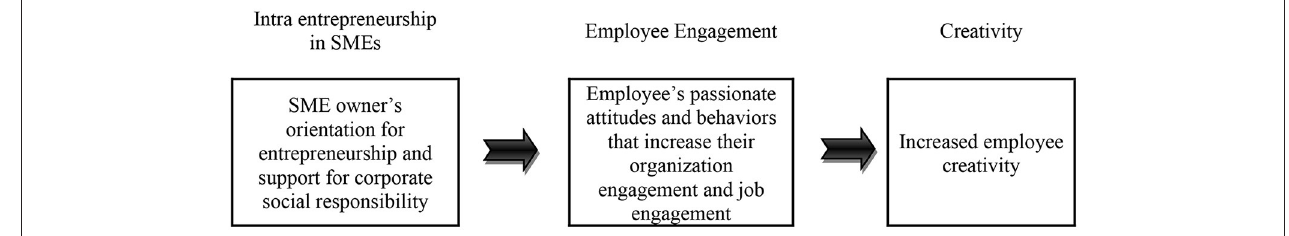
FIGURE 1 | Theoretical